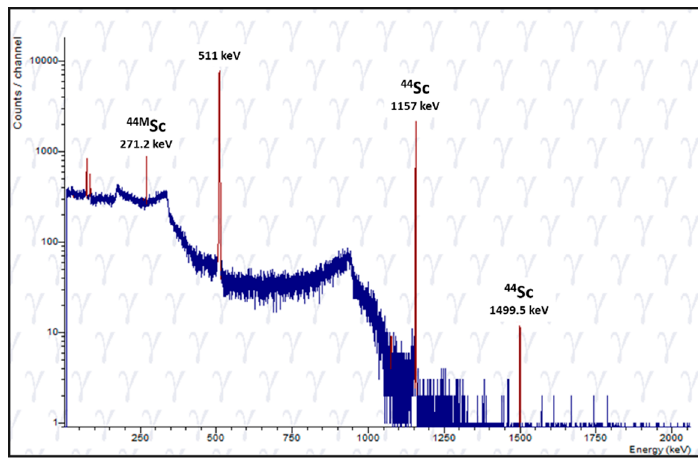
Figure 7. Representative γ -spectrum of 44 Sc eluate from irradiated Ca targets, indicating the product is radionuclidically pure.